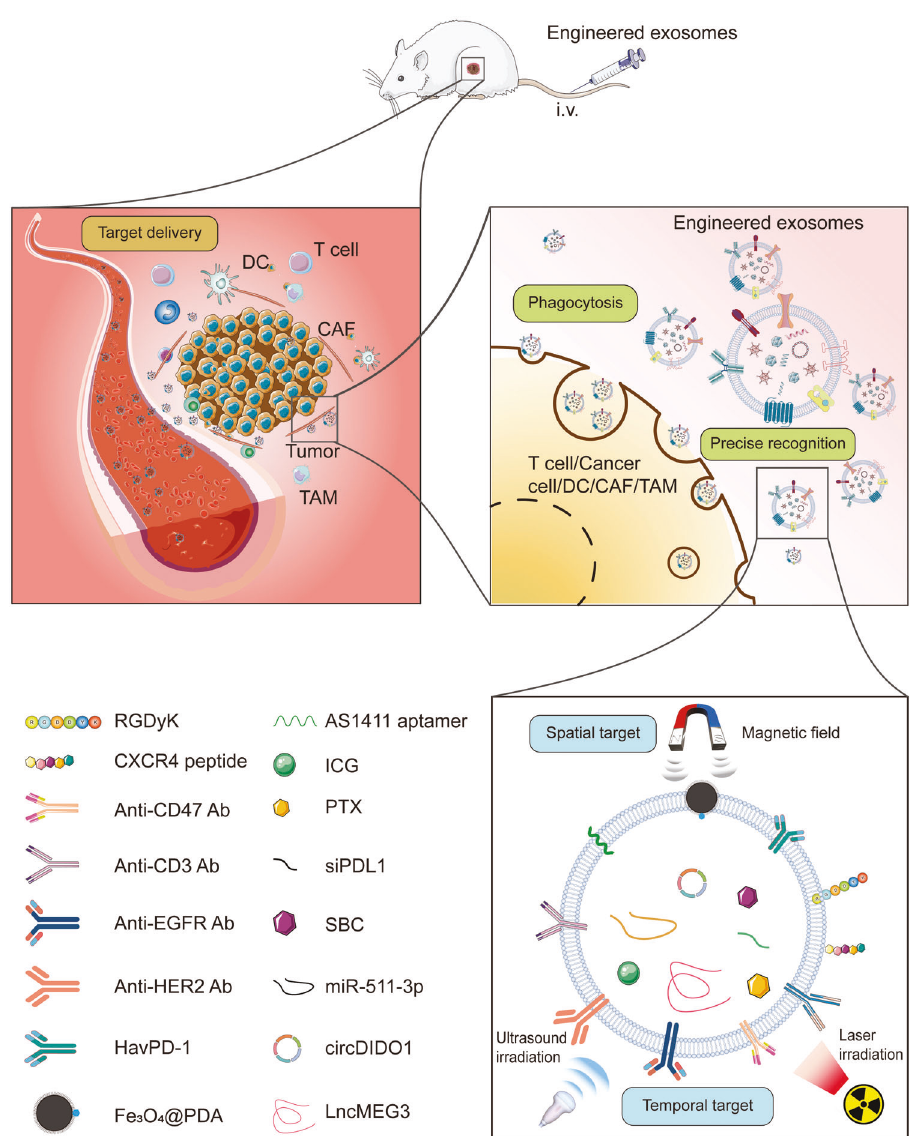
magnetic fi eld. Then the chemotherapeutic drugs, such as PTX, the ncRNAs, such as miR-551-3p, immune molecules, such siPDL1, were released into the tumor microenvironment (TME). Thereafter, the internalization of engineered exosomes led to tumor cell death, such as